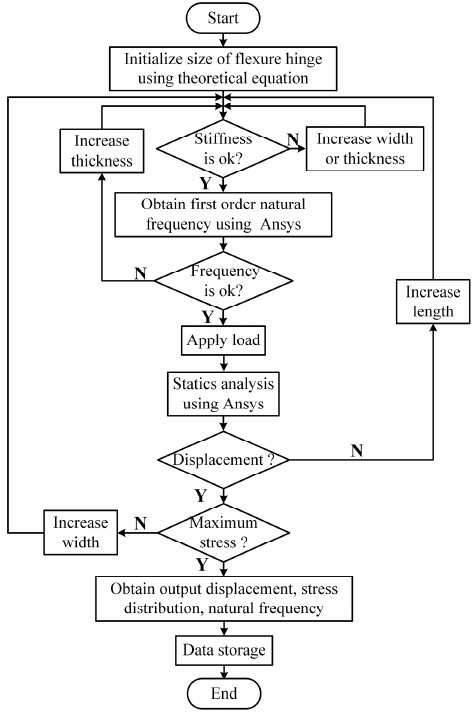
Figure 4. Flow chart to design dimensions of the flexure hinge. Reproduced with permission from [31].